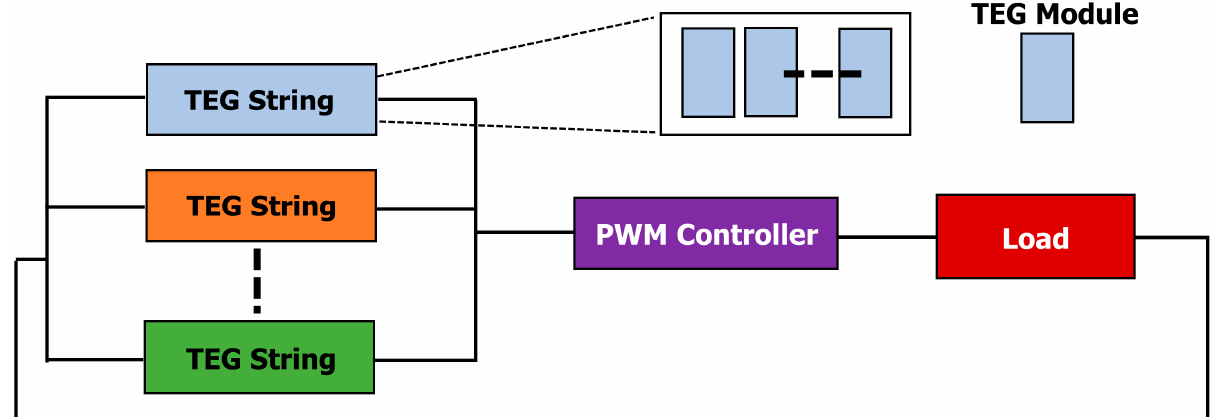
Figure 1. TEG systems comprising of multiple TEG strings connected to a PWM controller and a load. The TEG module’s internal architecture and loaded circuit are shown in Figure